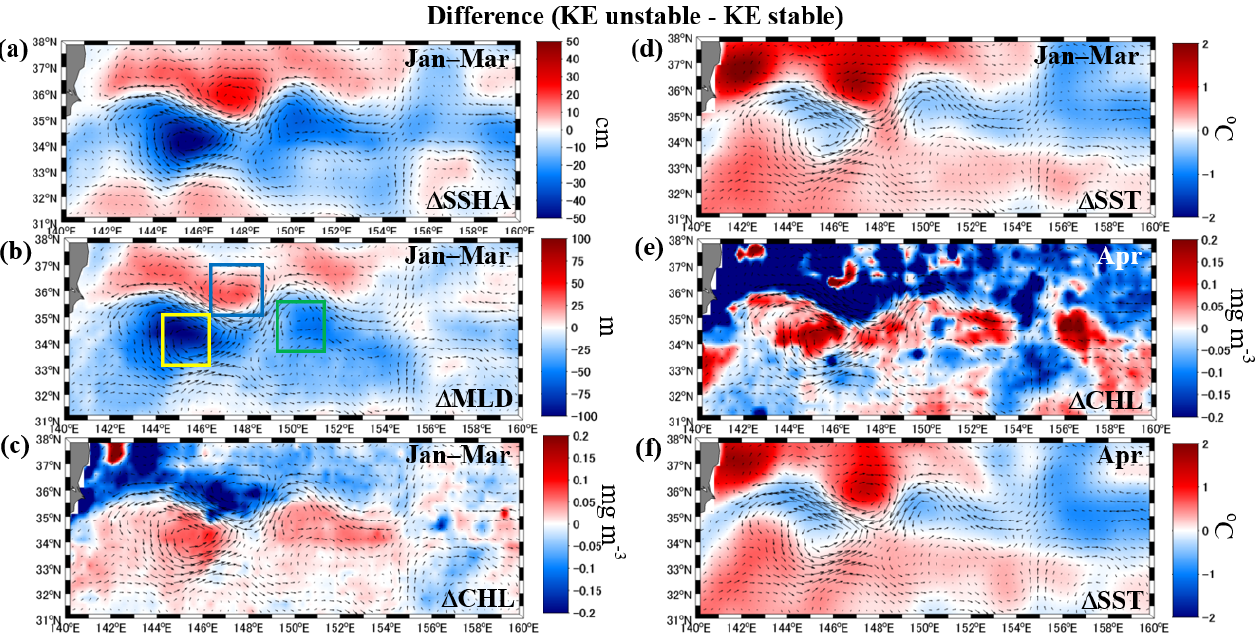
Figure 3. ( a ) Average difference of winter (January–March) sea surface height anomalies ( Δ SSHA) during the periods of unstable and stable Kuroshio Extensions (KEs) calculated by subtracting mean SSHA during years of stable KEs from the mean SSHA during years of unstable KEs. Panels ( b , c , d ) are the same as ( a ), except that they show differences in mixed layer depth ( Δ MLD), chlorophyll-a concentration ( Δ CHL), and sea surface temperature ( Δ SST), respectively. Panels ( e , f ) are Δ CHL and Δ SST, respectively for April. Vectors in ( a – f ) represent the average difference of the ocean surface currents based on Ocean Surface Current Analysis Real-Time data during periods of unstable and stable KEs. The yellow, green, and blue boxes are the same as those in Figure 4b,c and represent the areas from which the data were extracted to be shown in Figure 5.